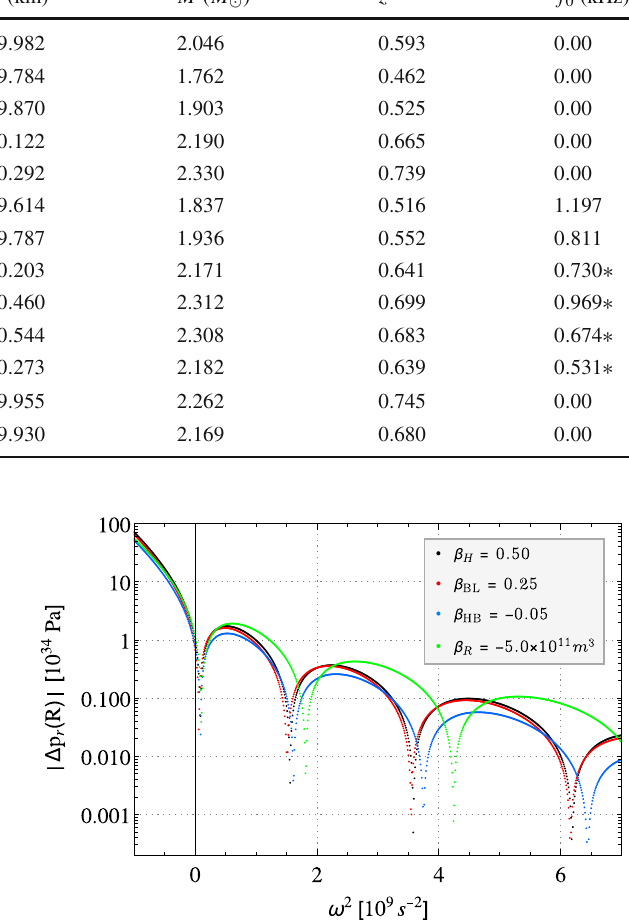
In Table 1, we list the mass and radius of the maximum- massconfigurationsforeachanisotropicmodelwithdifferent values of the free parameter. According to the M (ρ c ) method, the first maximum on the M (ρ c ) curve corresponds to a crit- ical central density ρ c = ρ crit which delimits a family of stars that is stable against gravitational collapse. This means after the critical density where dM / d ρ c < 0. Due to its sim- plicity, this condition has been widely used in the